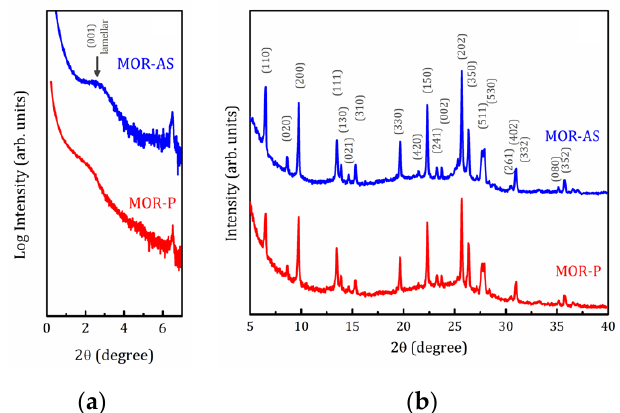
Figure 1. Small-angle ( a ) and full ( b ) XRD powder patterns for the mordenite samples as synthetized (MOR-AS) and pillared (MOR-P).